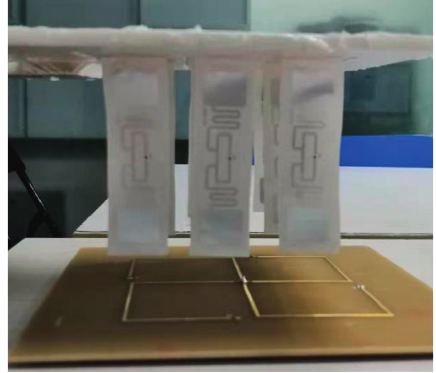
Figure 9: Four-branch antenna measurement setup.